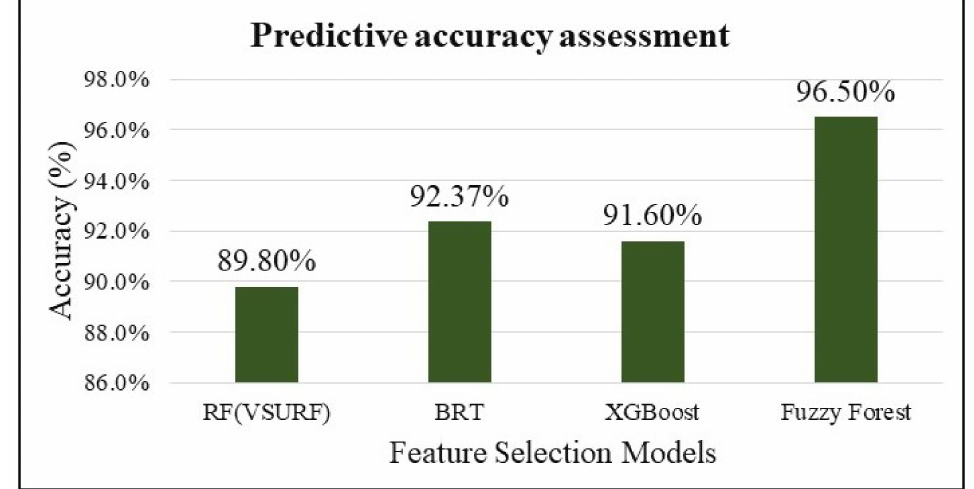
Figure 7. Predictive accuracy of implemented models. Accuracy assessment is performed using 10-fold cross-validation